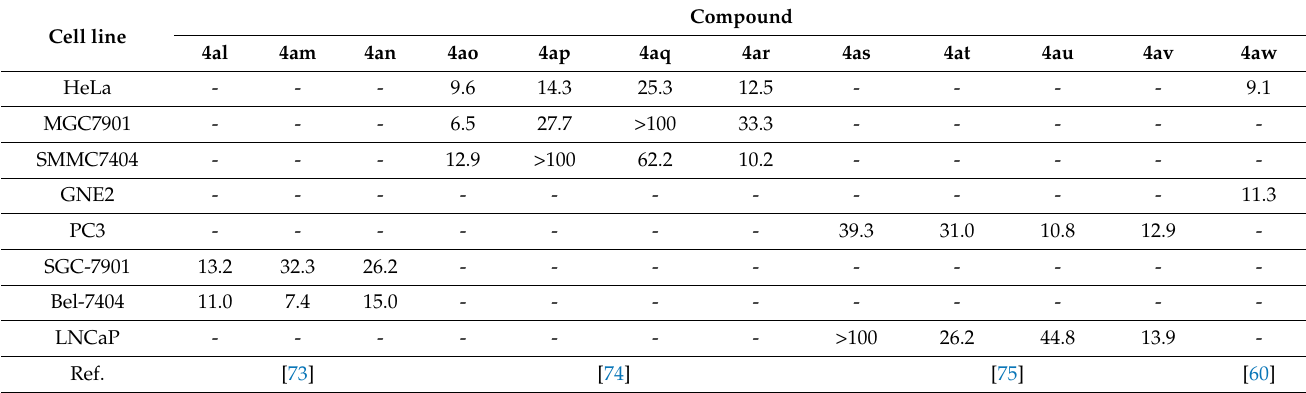
Table 6. - IC 50 values ( µ M) of the synthesized cholestane oxime